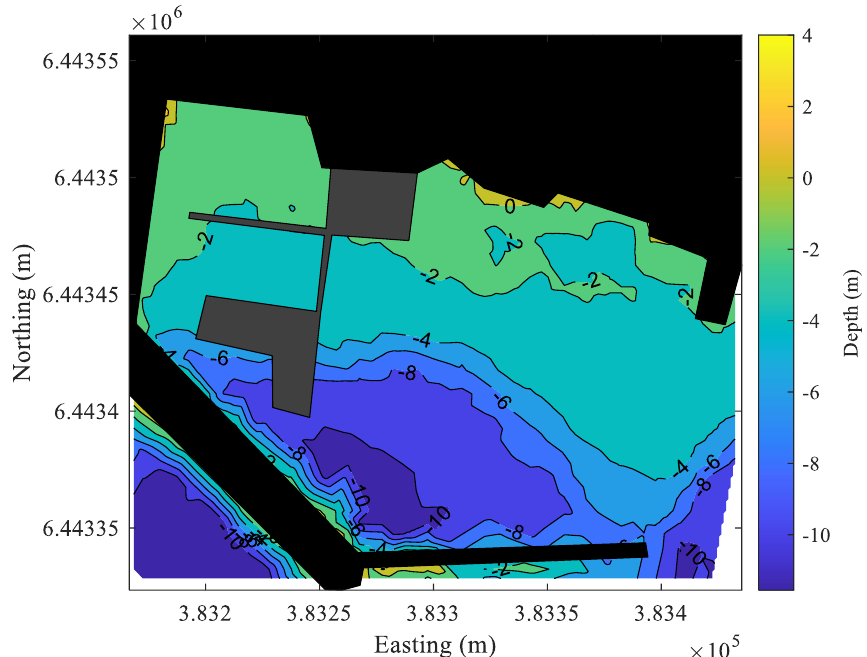
Figure 3. Bathymetry map of Northern Harbour generated from LIDAR data; data provided by [52].